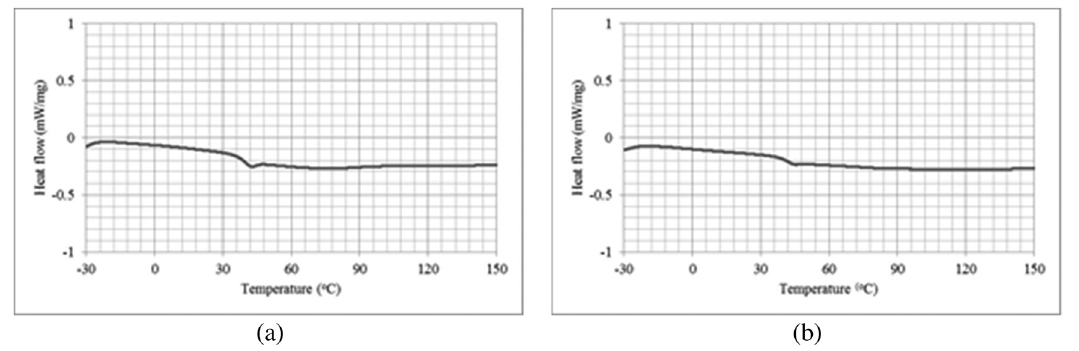
Figure 2: Thermogram of PVAc in the temperature range 38.29 – 42.88°C, with fl exion at 39.14°C ( a ) , and 39.37 – 43.68°C with fl exion at 40.96°C ( b ) .